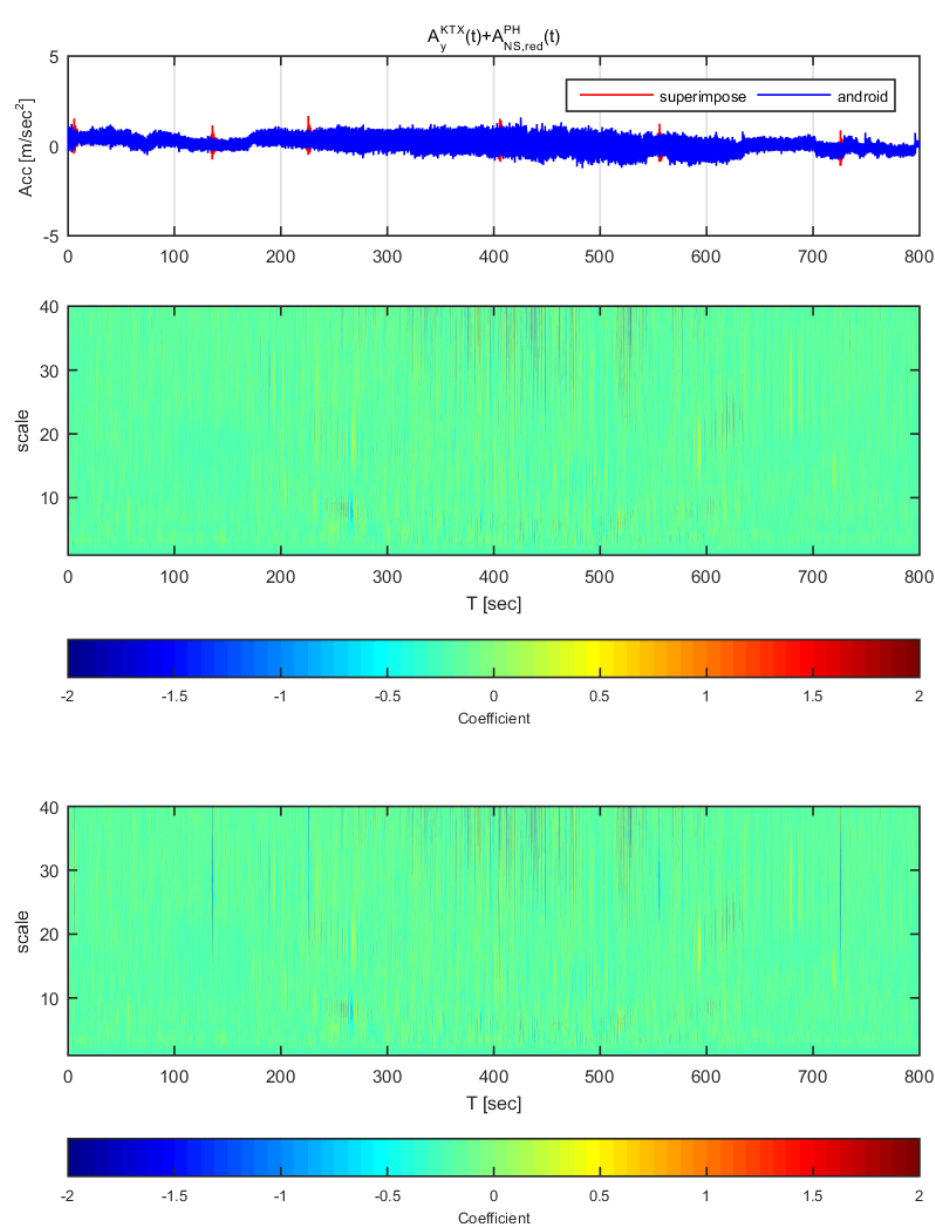
Figure 22. Wavelet transform coefficients for the combination of Korea Train Express (KTX) transverse direction data and Pohang earthquake north-south direction data (adjusted to 1 m/s 2 ).